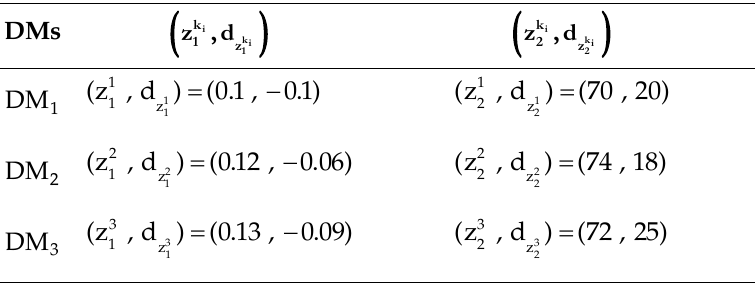
Table 2. Information of the decision